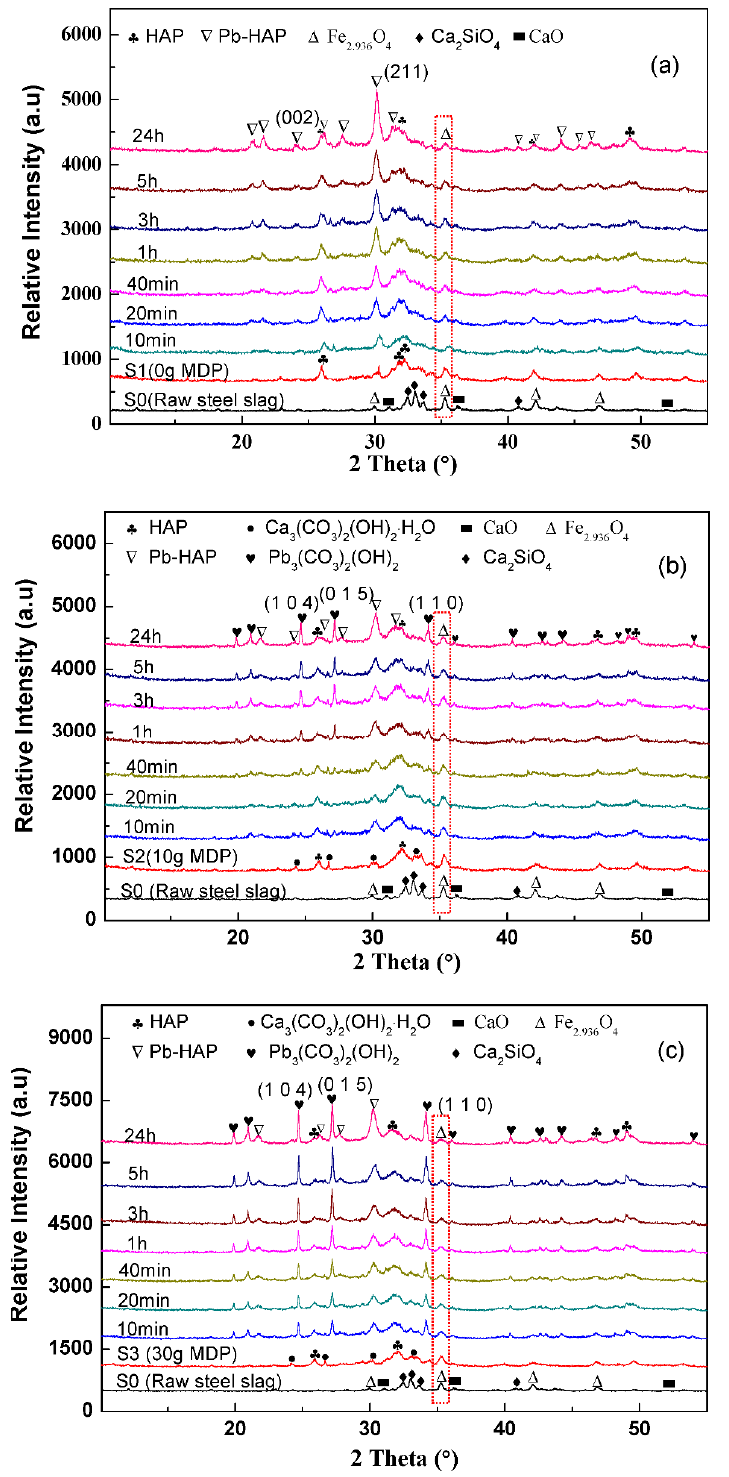
Figure 8. XRD patterns of raw steel slag and the three nanocomposite samples before and after adsorption at different times, with an initial Pb 2+ concentration of 700 ppm: ( a ) S1 (0 g MDP), ( b ) S2 (10 g MDP), and ( c ) S3 (30 g